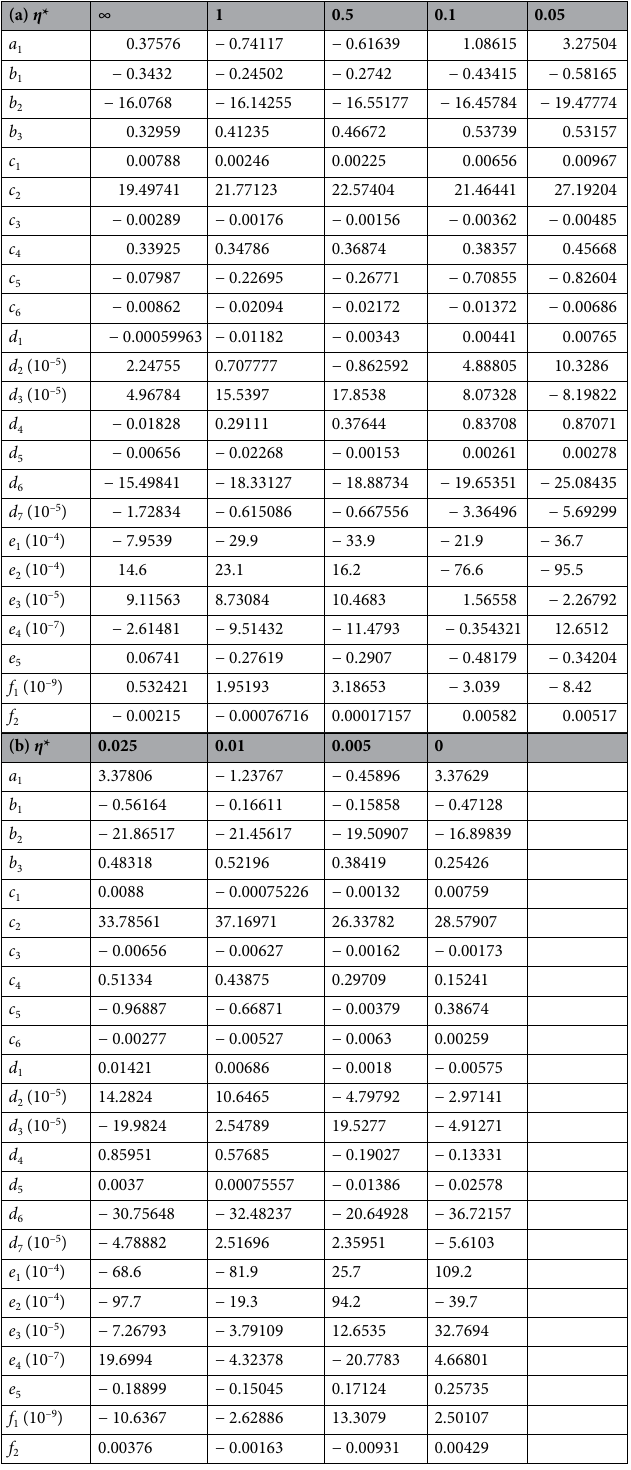
Table 12. Coefficients in f 1 : (a) when η * = ∞, 1, 0.5, 0.1, 0.05; (b) when η * = 0.025, 0.01, 0.005,